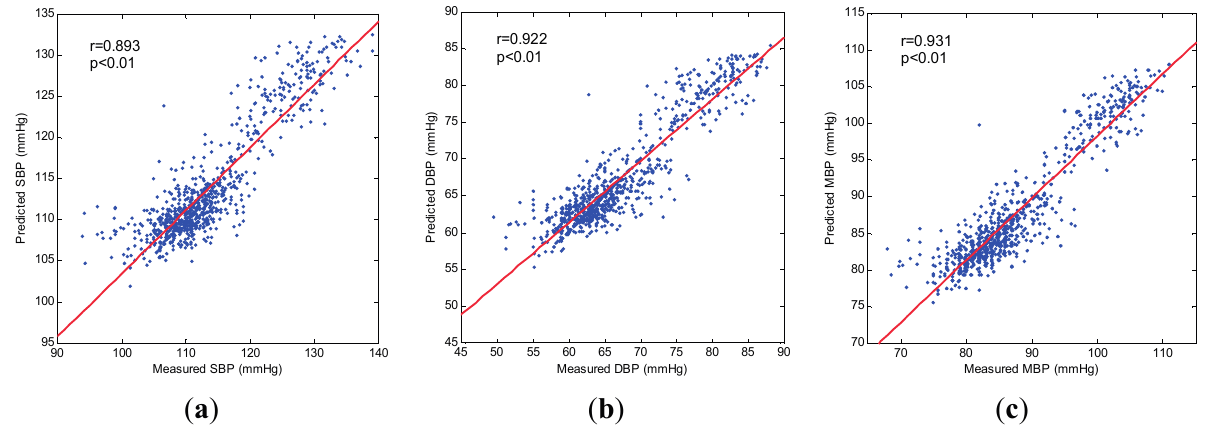
Figure 7. Correlation analysis between predicted values and measured values for ( a ) Systolic blood pressure (SBP); ( b ) Diastolic blood pressure (DBP); ( c ) Mean blood pressure (MBP). In each plot, the diagonal is the linear regression line; r, Pearson correlation coefficient.